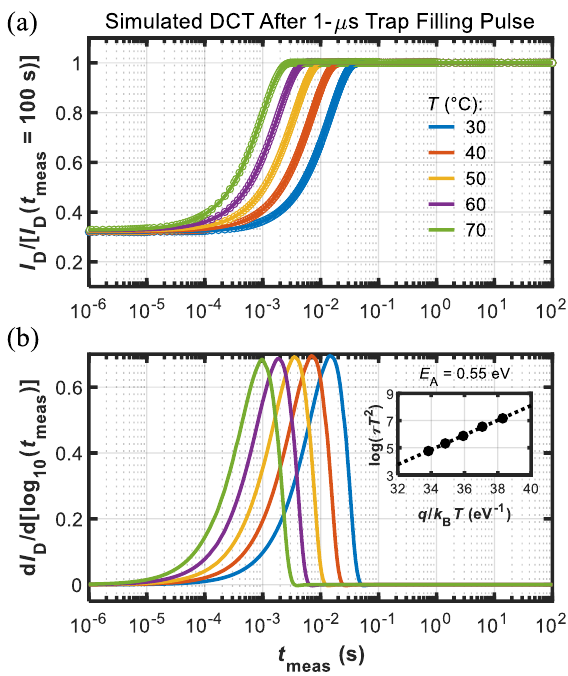
Figure 7. ( a ) Simulated DCTs at different temperature (see legend) after the short 1 us trap-filling pulse (dots are data and lines are fitting functions). Current was normalized to final value, i.e., I D ( t meas = 100 s). ( b ) d I D /d[log10( t meas )] used for the extraction of the time constants ( τ ) to build the Arrhenius plot (see inset) that yielded E A = 0.55 eV.